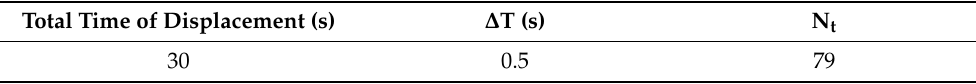
Table 3. Time features of the landslide displacement in its subaerial phase.